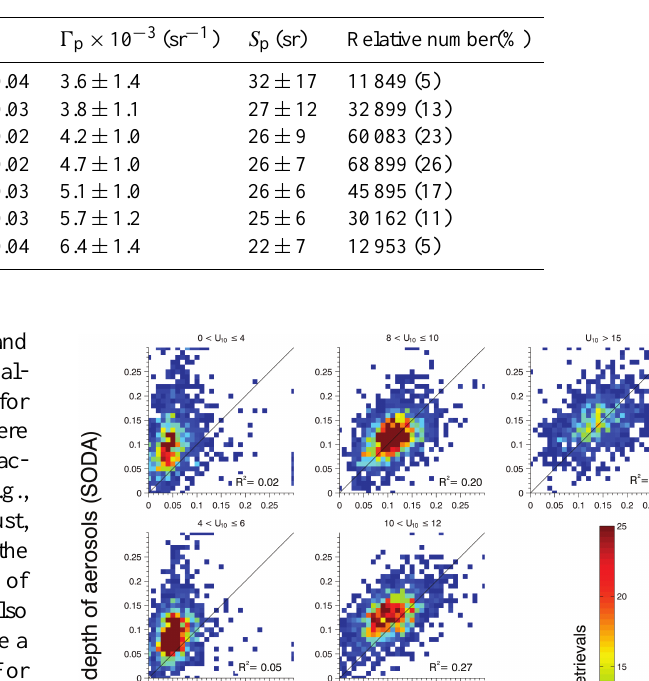
Table 2. Means ± 1 standard deviation for 2 ◦ × 5 ◦ grid cell medians for various AMSR-E wind speed regimes. The subscripts p , S and C appended to τ stand for particulate, SODA and CALIOP, respectively, where τ is the AOD.